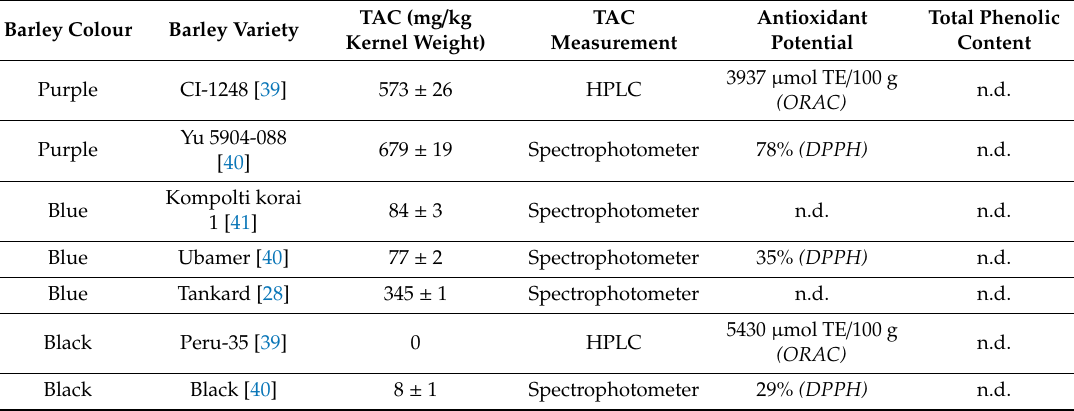
Table 2. Selection of studies focusing on total anthocyanin content (TAC) in various barley cultivars. The anthocyanin quantification method and assay used for antioxidant potential are also listed.